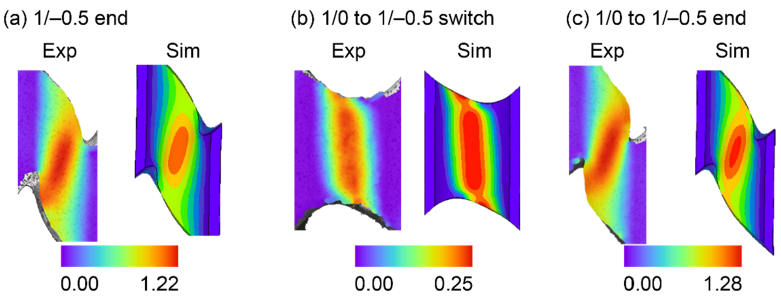
Figure 4. First principal strain fields of the notch surface for the DIC measurements (respectively left) and the numerical simulations (respectively right) for load cases 1/ − 0.5 ( a ) and 1/0 to 1/ − 0.5 ( b , c ).